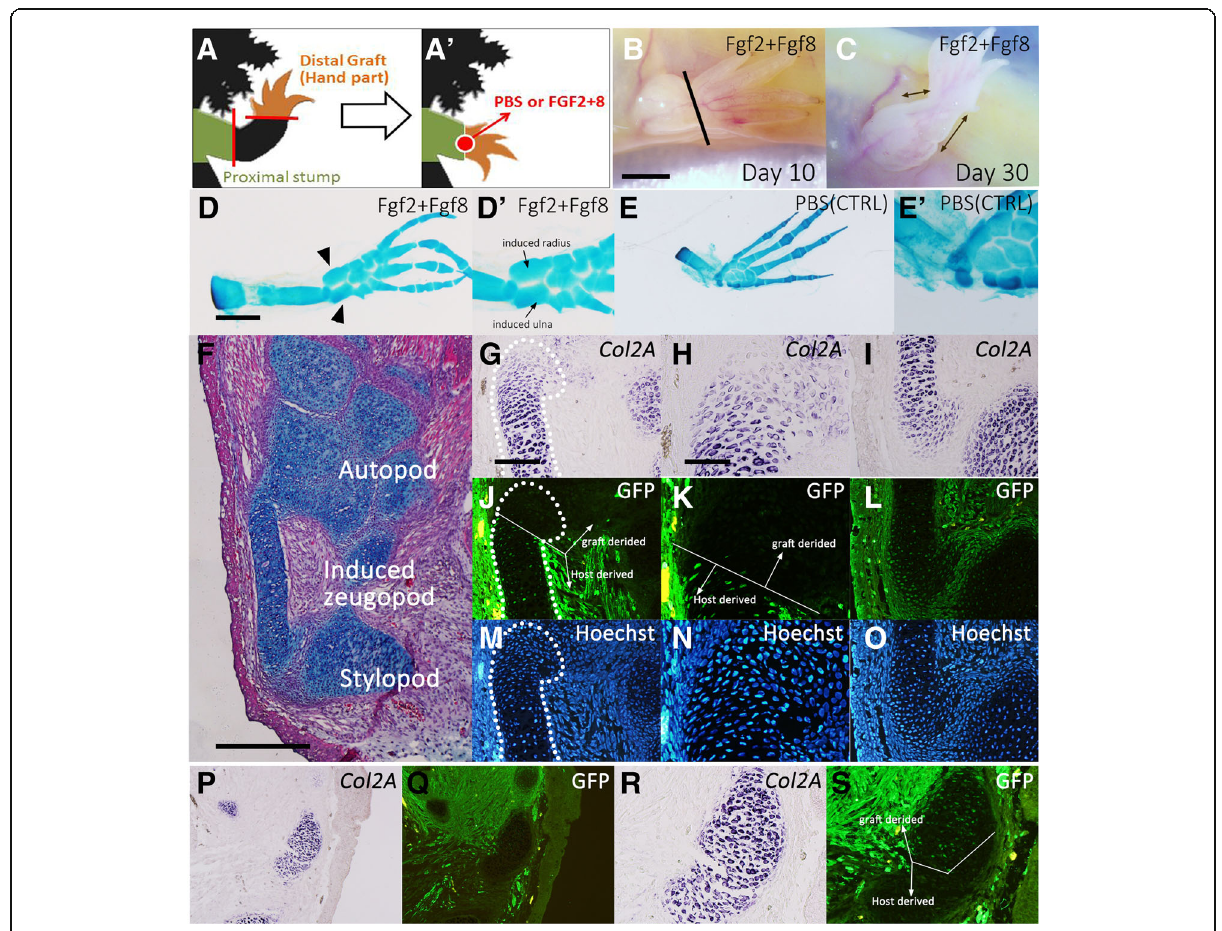
recognizable between the grafted hand and the stump (double-headed arrows). d , e Skeletal pattern was revealed by Alcian blue staining. d Fgf2 + Fgf8 bead-grafted sample. Arrowheads indicate the two induced cartilages between the graft and the stump. (D ’ ) Higher